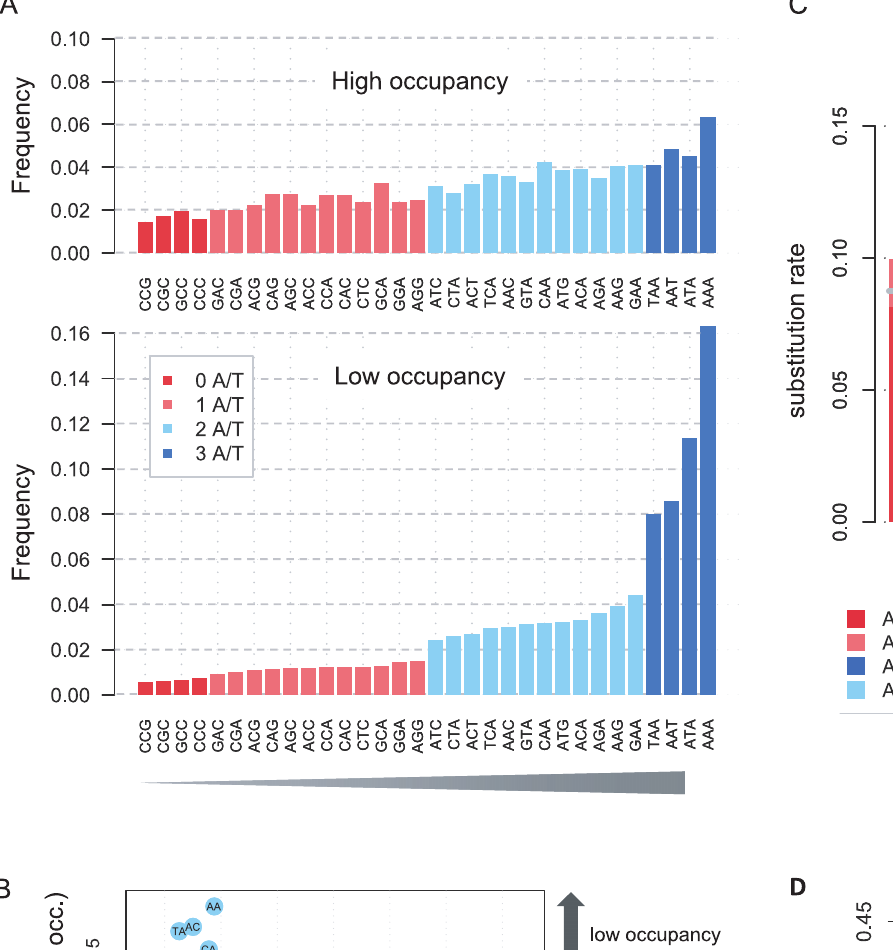
PLoS Computational Biology |